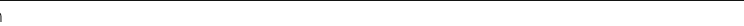
Table 2 Description of the identified